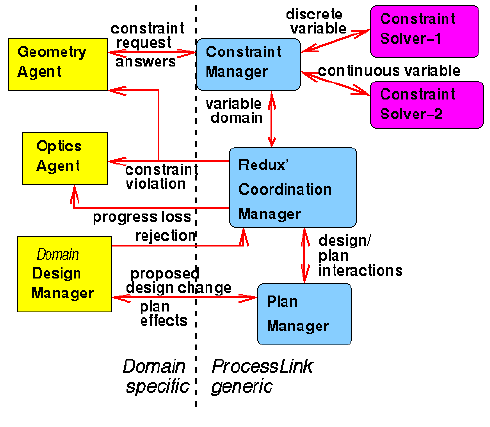
Figure 3. A ProcessLink Architecture.